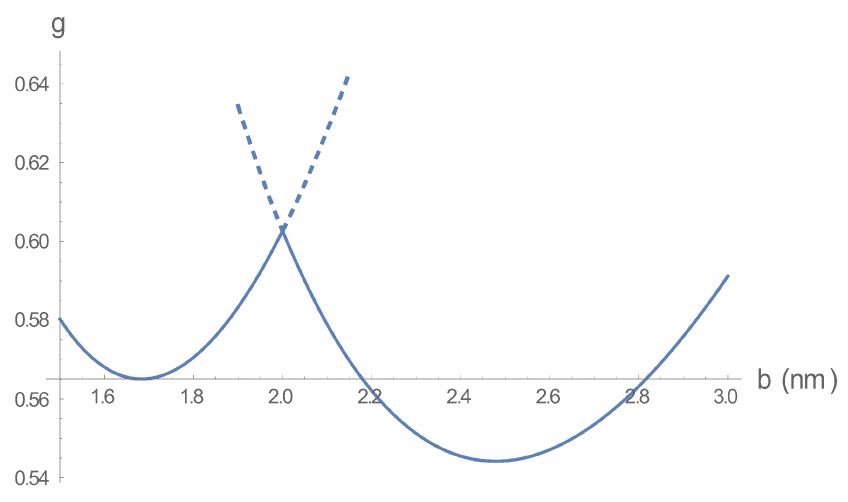
Figure 3. The free energy (per bead, in units of k B T ) as a function of bead spacing for a Bjerrum length l B = 2.0 nm lying within the transition range in Figure 2; the spring constant and salt concentration are the same as in Figure 2. g = g cc ( b ) for b < 2.0 nm, g = g dh ( b ) for b > 2.0 nm. The dashed continuations are forbidden, so there is a maximum at l B = 2.0